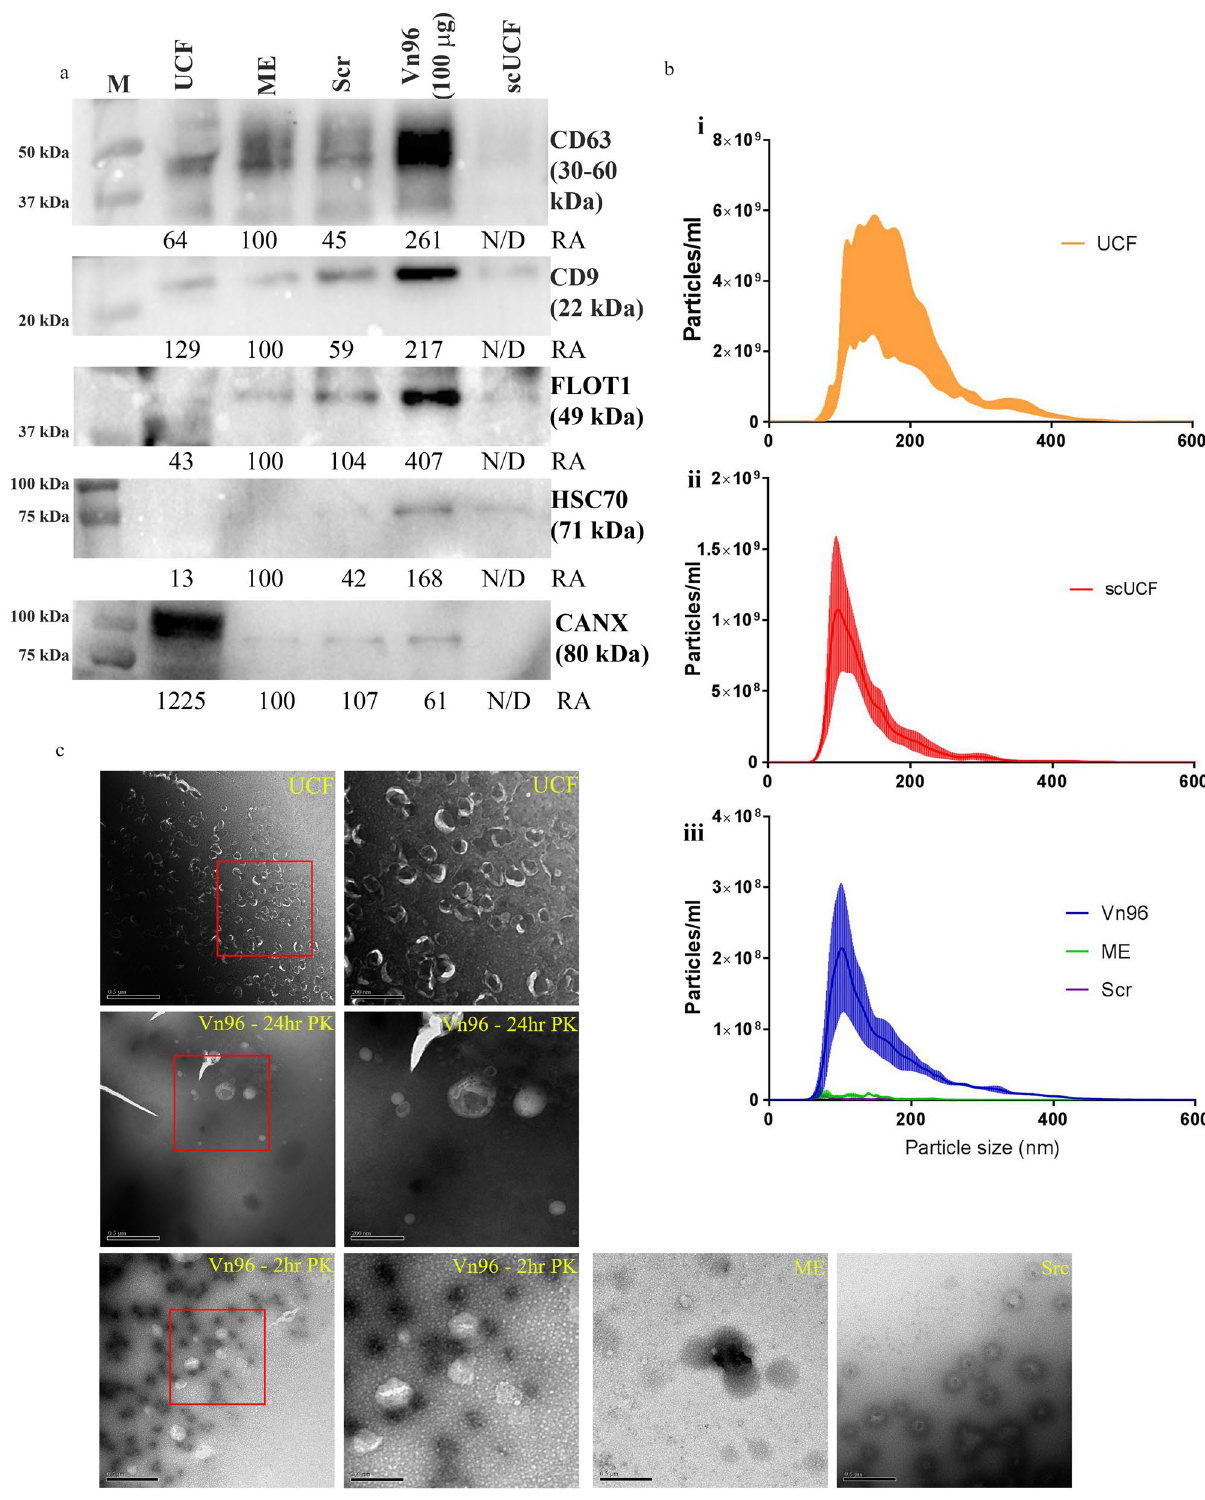
Figure 2. Characterization of plasma EVs isolated by UCF, scUCF and Vn96 methods, all from the same donor plasma (n = 3). ( a ) Representative Western blot comparing different EV isolation methods probing for canonical EV markers: CD63 (65 kDa), CD9 (24 kDa), FLOT1 (50 kDa), HSC70 (73 kDa), and cytoplasmic marker CANX (75 kDa). Mean relative abundance (RA) for three experiments is indicated below each Western blot (ME is set at 100). Full-length blots and all biological replicates are presented in Supplementary Fig. 3. ( b ) NTA results showing the number of particles ± SEM per mL of starting plasma on the y-axis plotted against the size (nm) of particles on the x-axis from UCF (i), scUCF (ii), and Vn96 with appropriate controls (iii). ( c ) Representative TEM images of EVs captured by UCF, Vn96 (2 h and 24 h post proteinase K treatment), ME buffer and Scr